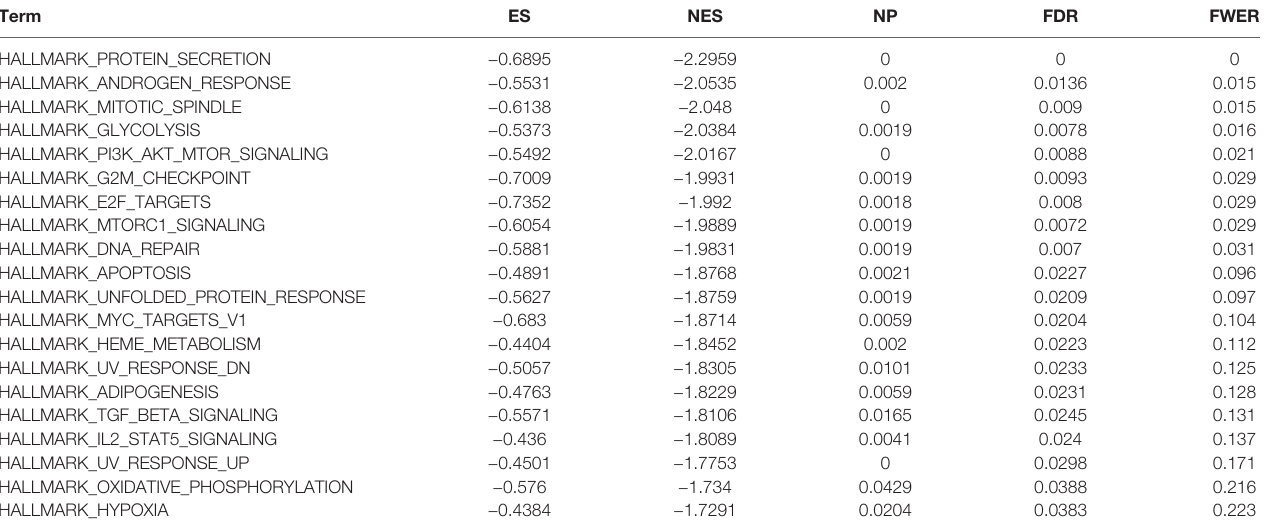
TABLE 2 | The information of HALLMARK terms from top 20 GSEA enrichment analysis. Term